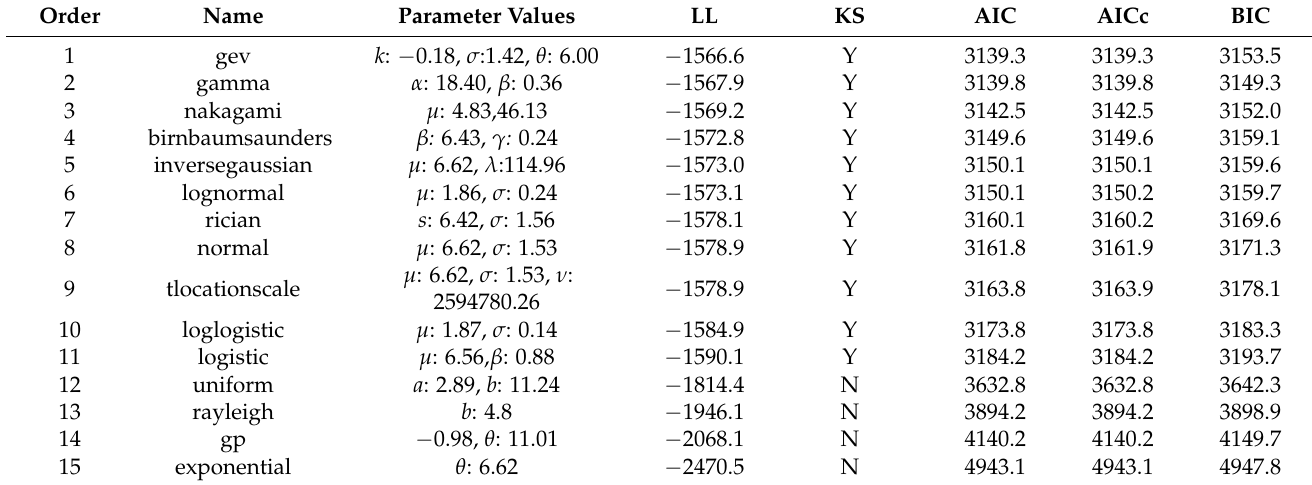
Table A5. Probability Distribution Rankings Using Different Goodness-Of-Fit Tests for Cluster.